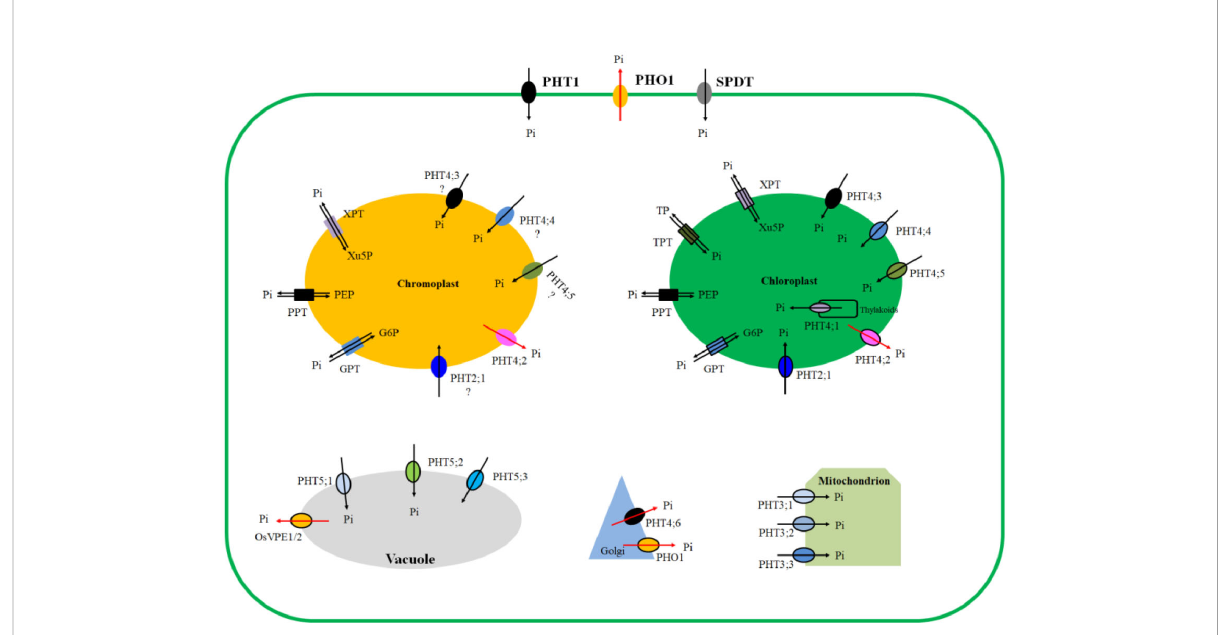
FIGURE 2 Subcellular locations of phosphate transport proteins. Plasma membrane located members: PHT1, PHO1, and SPDT. Golgi located members: PHT4;6 and PHO1. Mitochondrion located members: PHT3;1, PHT3;2, and PHT3;3. Vacuole located members: PHT5;1, PHT5;2, PHT5;3, and OsVPE1/2. Chloroplast located members: TPT, XPT, PPT, GPT, PHT2;1, PHT4;1, PHT4;2, PHT4;3, PHT4;4, PHT4;5. Chromoplast located members: XPT, PPT, GPT, PHT2;1, PHT4;2, PHT4;3, PHT4;4, PHT4;5. Chromoplast locations of PHT4;3, PHT4;4, PHT4;5 are proposed by speculation. Substrates transported are indicated by arrows. Note: PHT, phosphate transporter; PHO1, PHOSPHATE1; SPDT, sulfate transporter [SULTR]-like phosphorus distribution transporter; VPE, vacuolar phosphate ef fl ux transporter; TPT, triose-phosphate/phosphate translocator; PPT, phosphoenolpyruvate/phosphate translocator; XPT, xylulose 5-phosphate/phosphate translocator; GPT, glucose 6-phosphate/phosphate